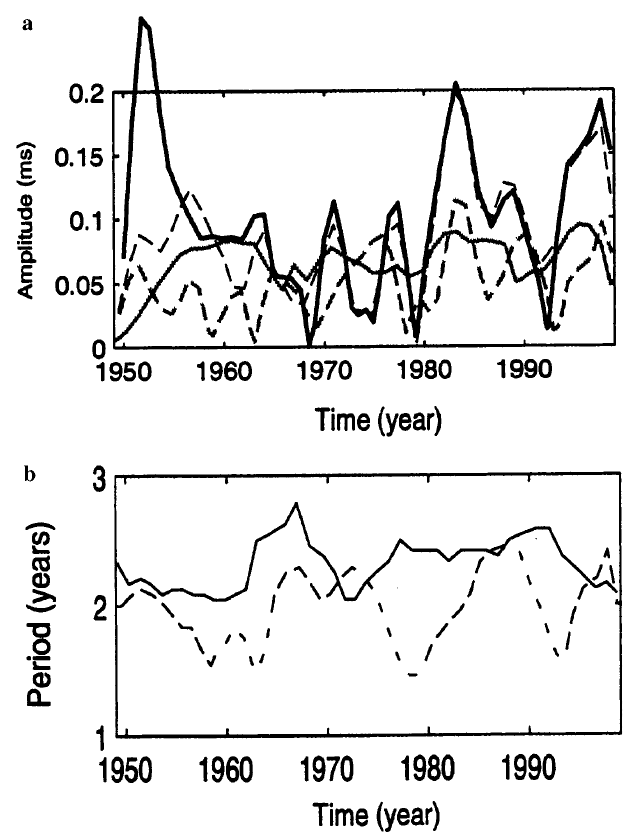
Fig. 10. a Amplitude variability of the quasi-biennial signal in the LOD ( bold solid line ), AAM (i.e. NCEP 10 ) ( dashed line ), S-QBO ( solid W line ), T-QBO ( dashed bold line ) time series. b Period variability of the quasi-biennial signal in the S-QBO ( solid ), T-QBO ( dashed ) time series